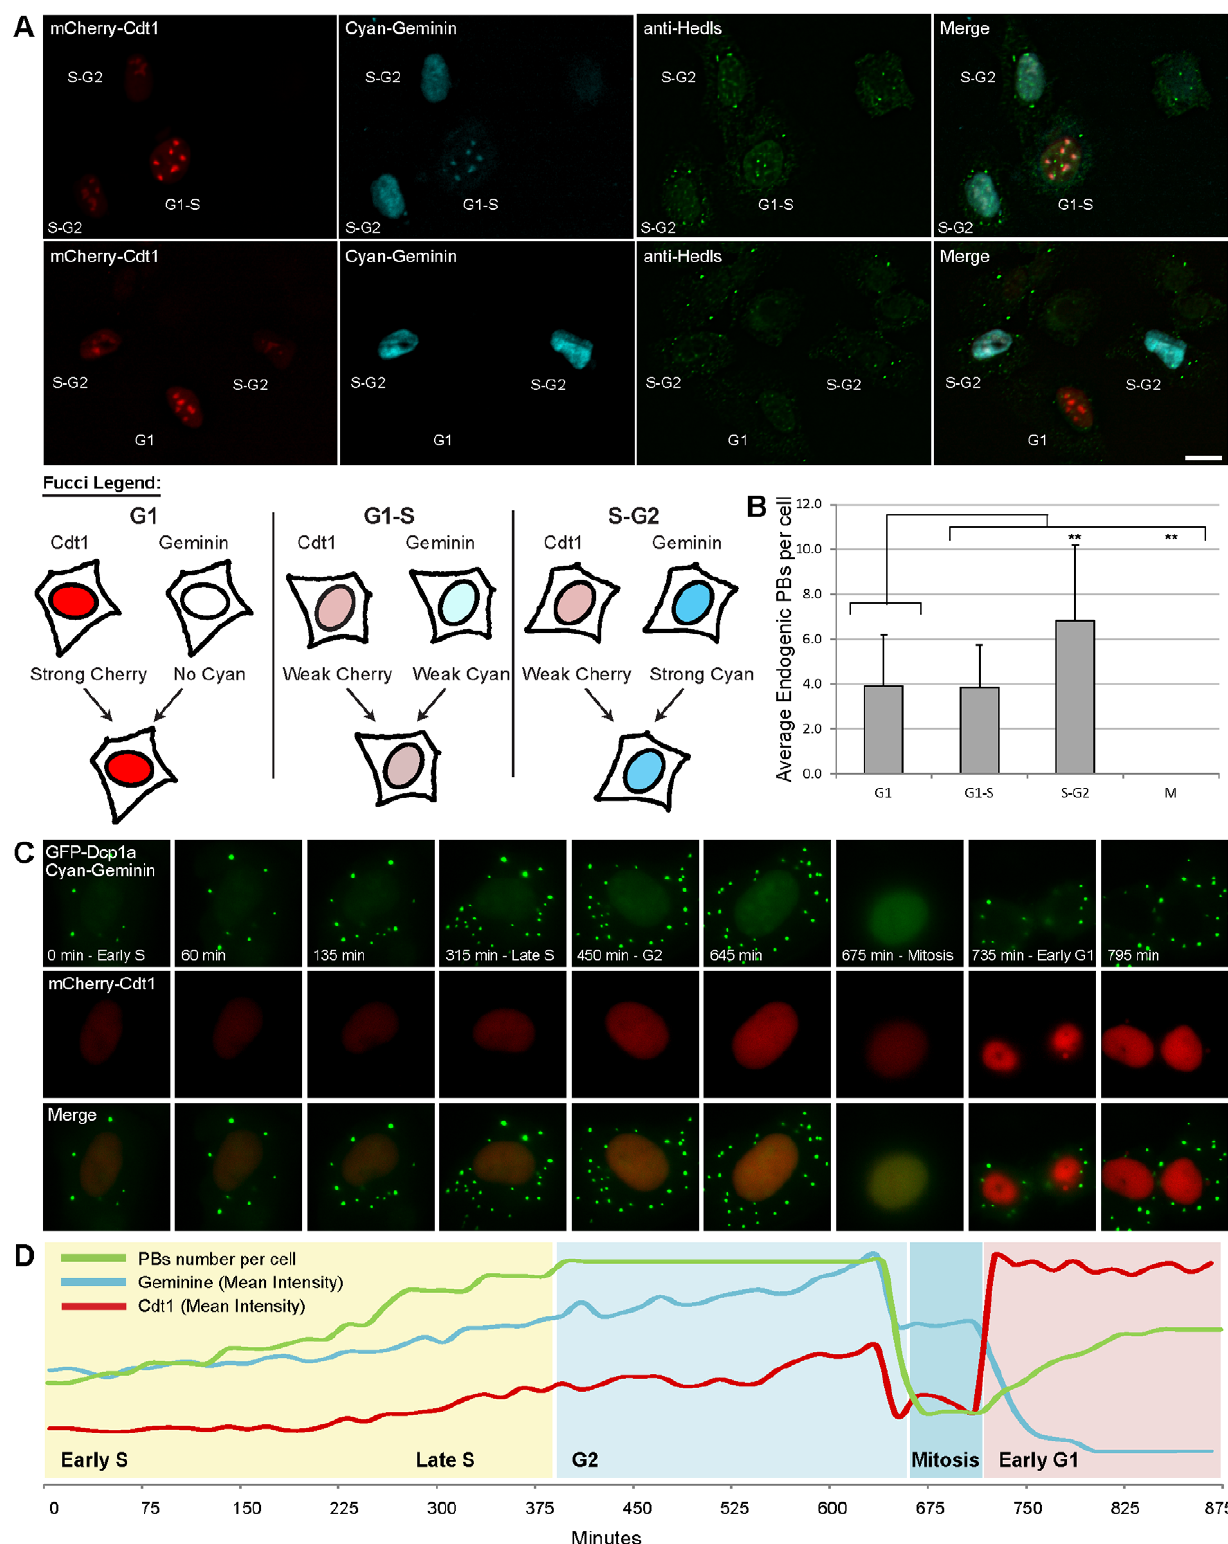
Figure 3. PB numbers increase as cells reach S/G2 phase of the cell cycle. (A) The Fucci markers mCherry-Cdt1 (red) and AmCyan1-Geminin (cyan) were expressed in U2OS cells and then cells were stained with an anti-Hedls (green) antibody to mark PBs. (Bar 20 m m). It was possible to detect the cell cycle phase using the intensity combination of the red and cyan markers in the cell, as explained in scheme below. (B) The number of PBs in each cell was counted and assigned a cell cycle phase according to the Fucci colors. The plot designates the average PB number in each phase (G1 n=40, G1/S n=15, S/G2 n=40, M n=10). Error bars represent STDEV and a T-Test was performed. (C) U2OS cells stably expressing GFP-Dcp1a